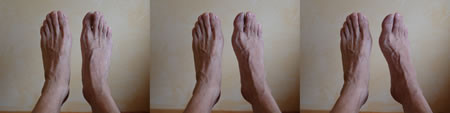
Description of the changes in foot alignment while lying supine in an unloaded position. The left panel shows a symmetrical position. The middle panel shows a slight displacement of the Y axis. The right panel shows a more pronounced displacement of the foot in the Y axis corresponding to inversion.